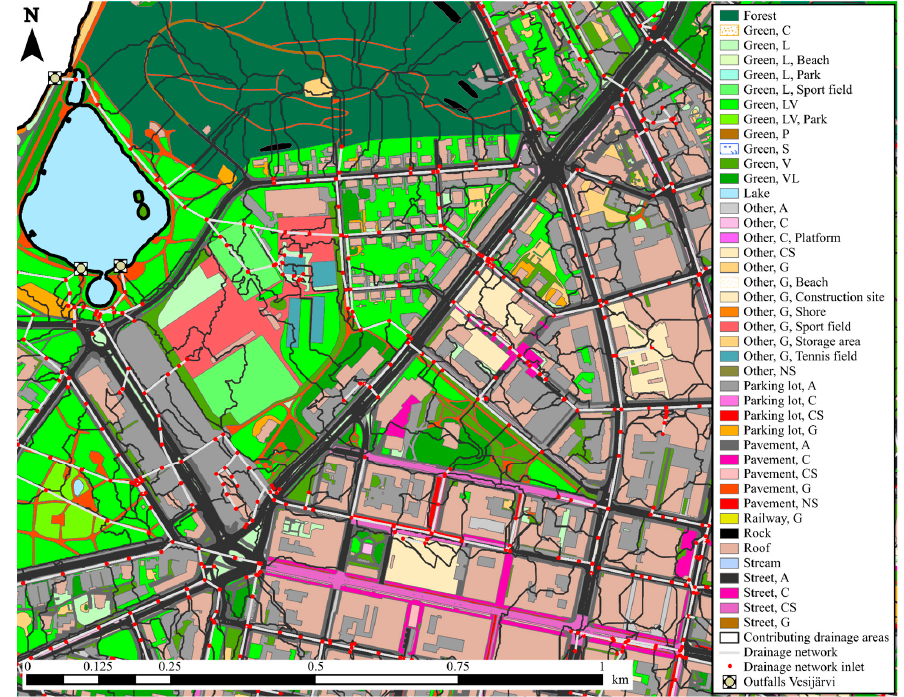
Figure 6. A section of the Vesijärvi catchment showing the surface discretization, the drainage network, and inlets along with their corresponding drainage areas (black boundary lines).